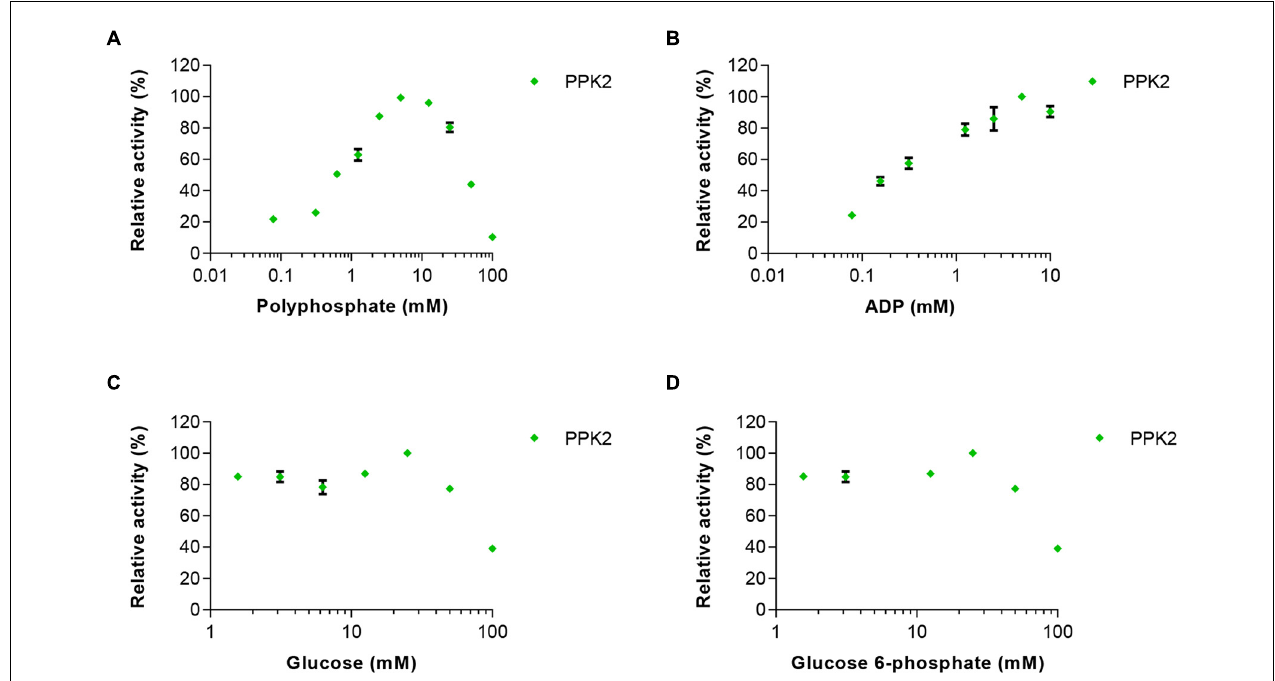
FIGURE 3 | Effects of increasing concentrations of the reaction substrates (A) polyphosphate and (B) ADP on PPK2 activity. In addition, the effects of (C) glucose and (D) glucose 6-phosphate on enzyme activity were tested. PPK2 activity was determined using a Luciferase ATP determination assay. All data represent mean and standard error of the relative activities measured in triplicates. Where not visible, the error bar is smaller than the symbol